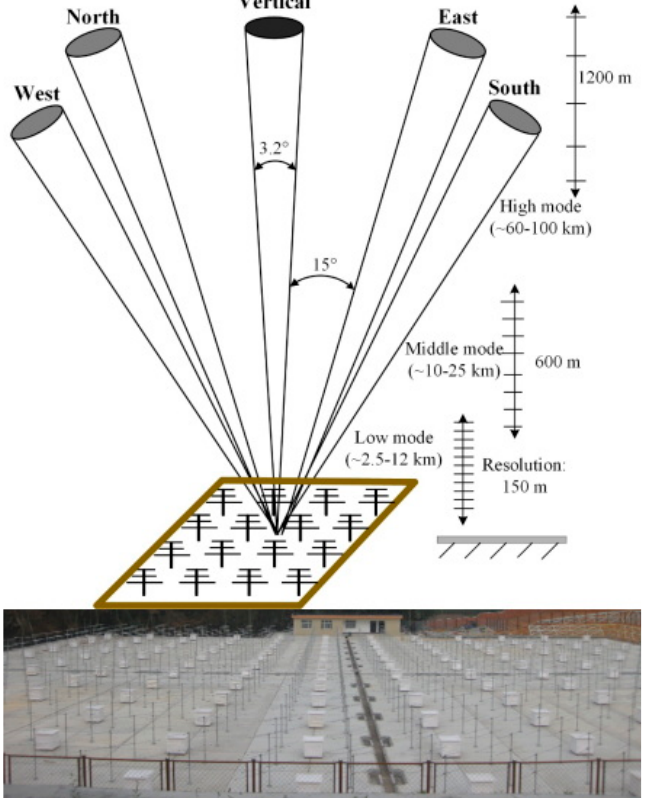
Figure 3. Bottom plot showing the antenna array of the Wuhan MST radar. The upper plot indicates the five beam swinging for atmosphere observations. The half power width of each beam is 3.2°, and the zenith angle of the oblique beams is 15°. The radar has three operating modes, including low, middle, and high modes.